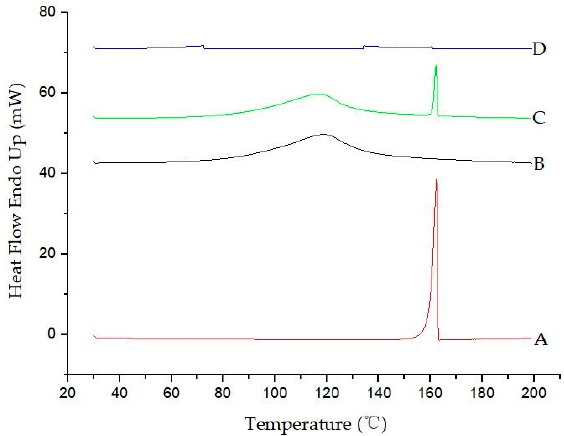
Figure 9. Differential scanning calorimetry (DSC) results: ( A ) diuron; ( B ) β -CD; ( C ) physical mixture; and ( D ) the inclusion complex.